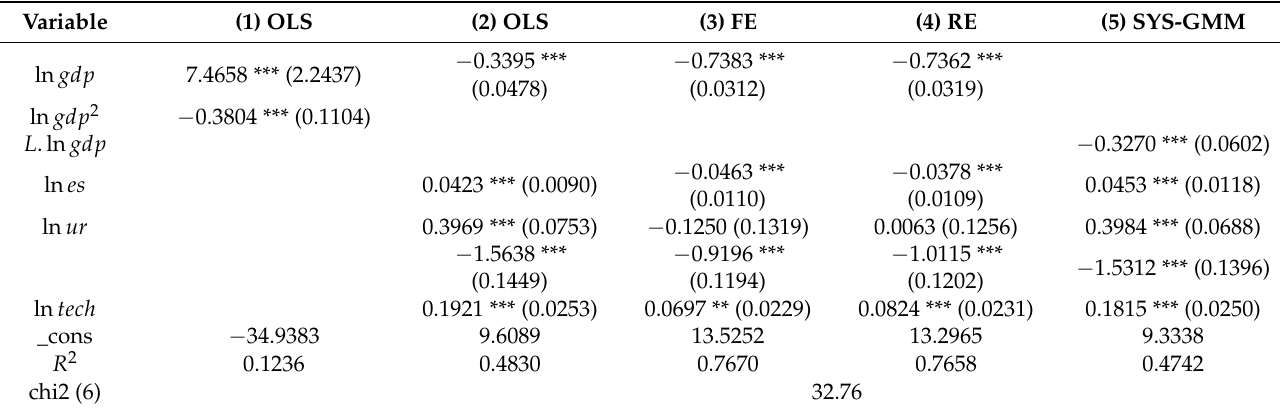
Table 2. Benchmark regression